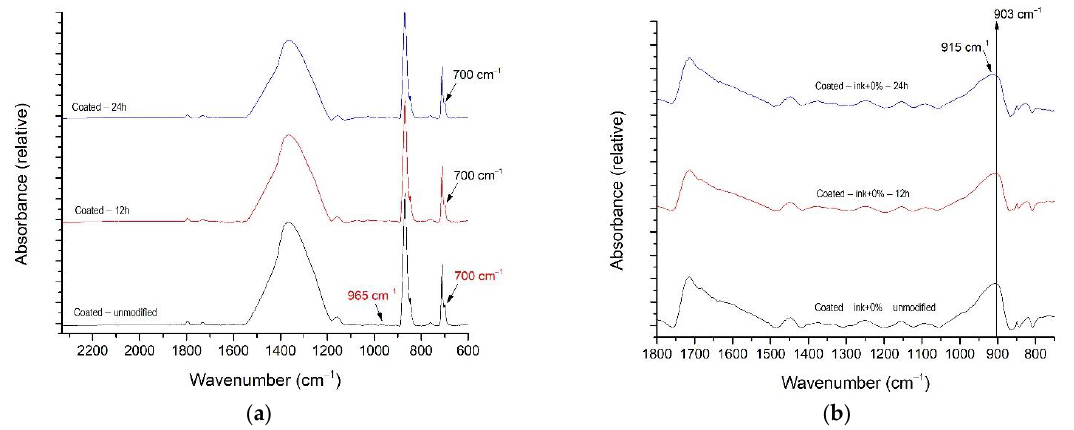
Figure 6. FTIR – ATR spectra of unmodified and modified samples; ( a ) coated paperboard and ( b ) Figure 6. FTIR–ATR spectra of unmodified and modified samples; ( a ) coated paperboard and printed ink on the coated paperboard without nanoparticles. ( b ) printed ink on the coated paperboard without